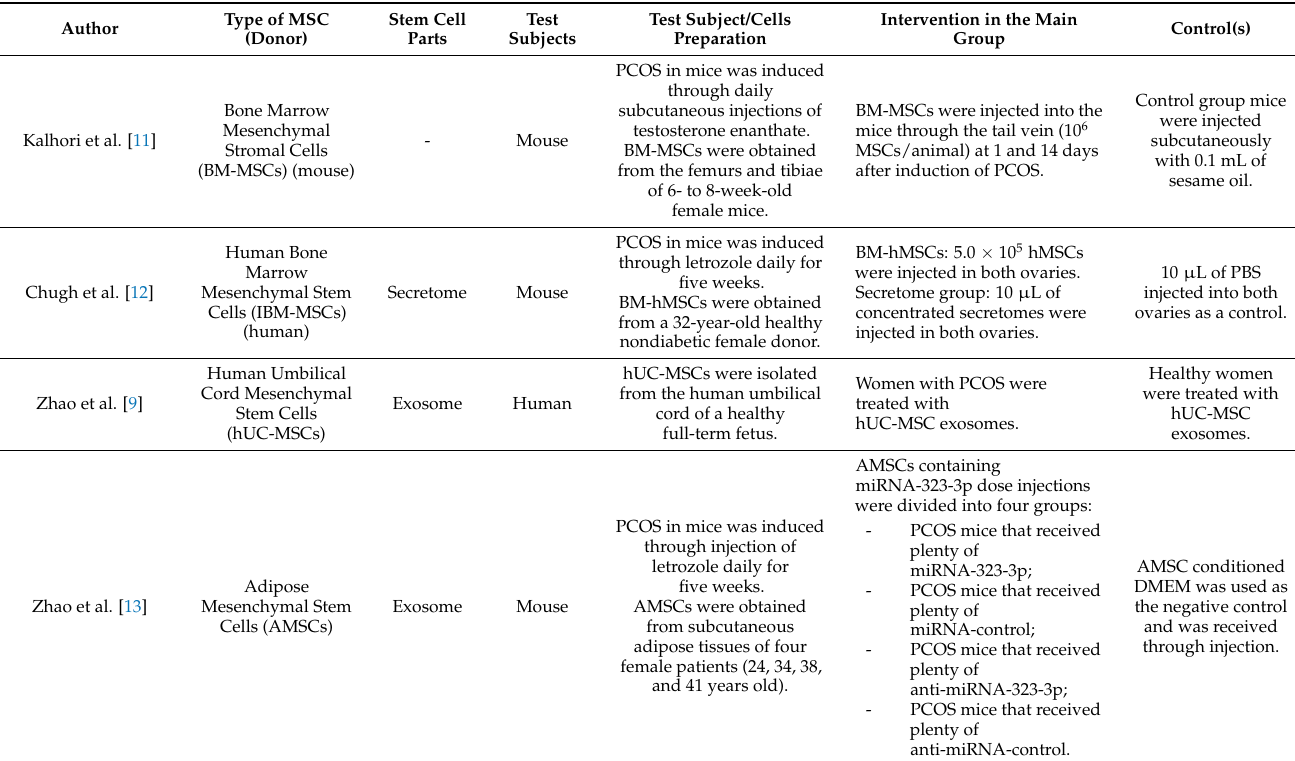
Table 1. Overview of the